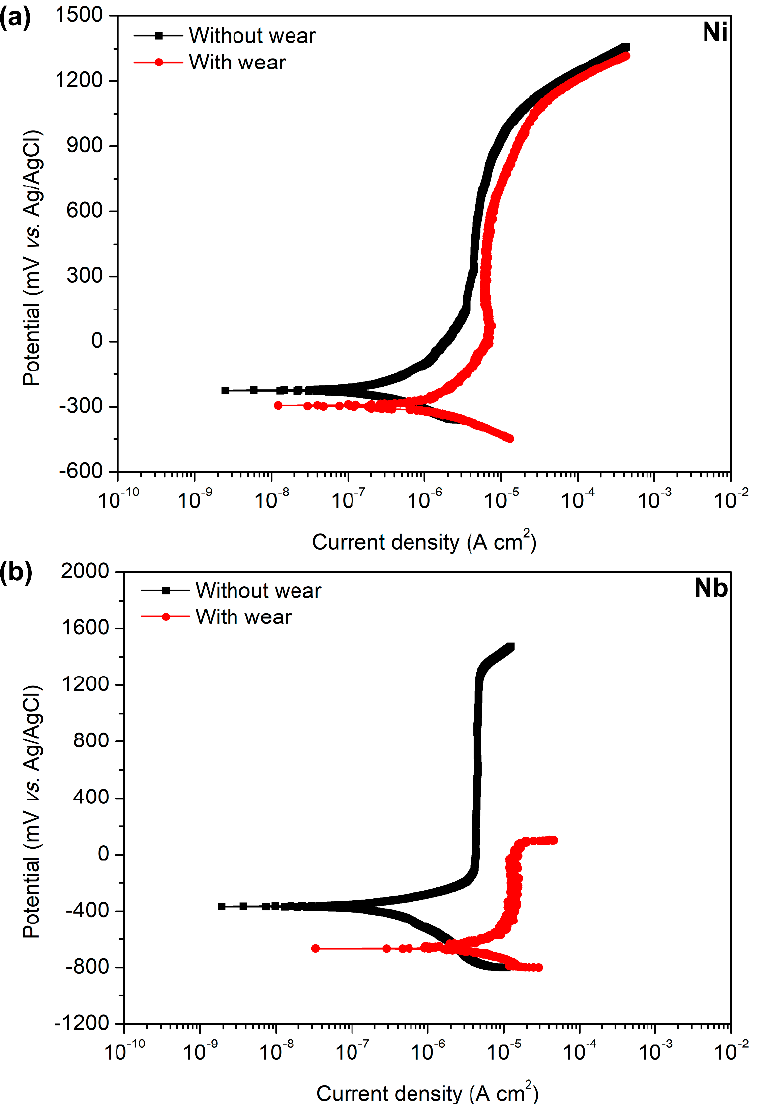
Figure 2. Potentiodynamic polarisation curves of ( a ) Ni and ( b ) Nb under different wear conditions in 5 wt.% Na 2 SO 4 solution. Table 1. Electrochemical corrosion parameters from the potentiodynamic polarisation curves.